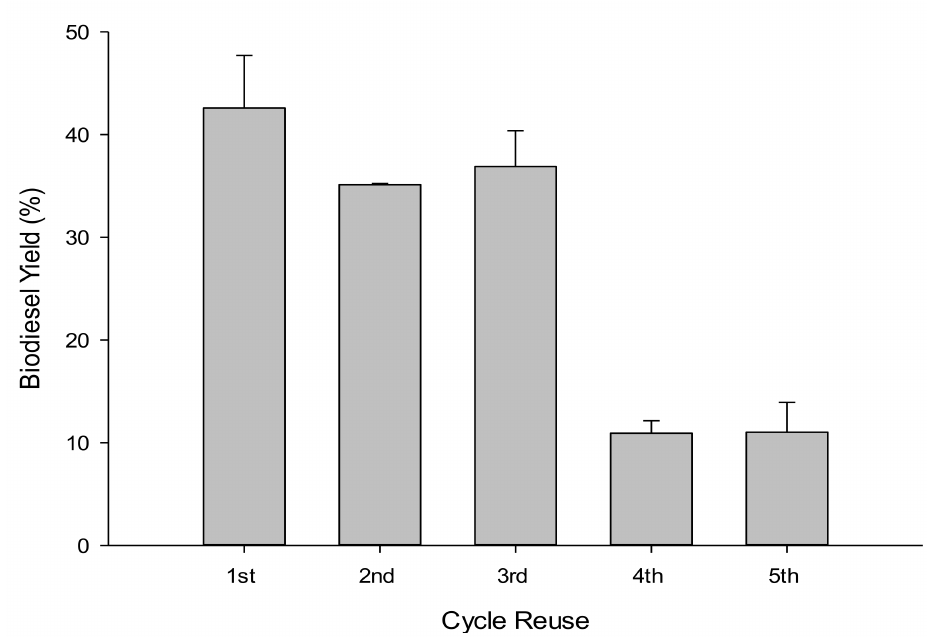
Figure 10. Biodiesel yield assessment in WFOs transesterification after NSh-HZSM-5